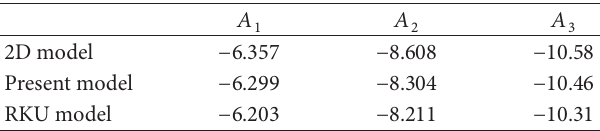
Table 5: Logarithm of the resonance peak amplitude (m) of the free edge with core layer thickness 𝐻 2 = 1 mm.